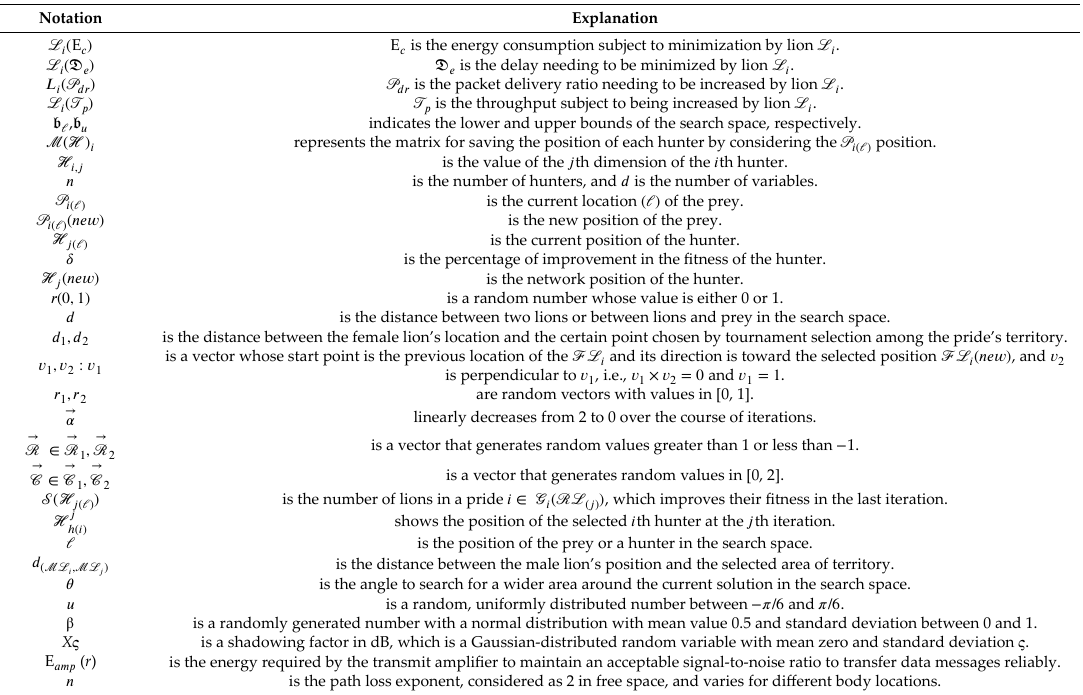
Table 2. Notations used in